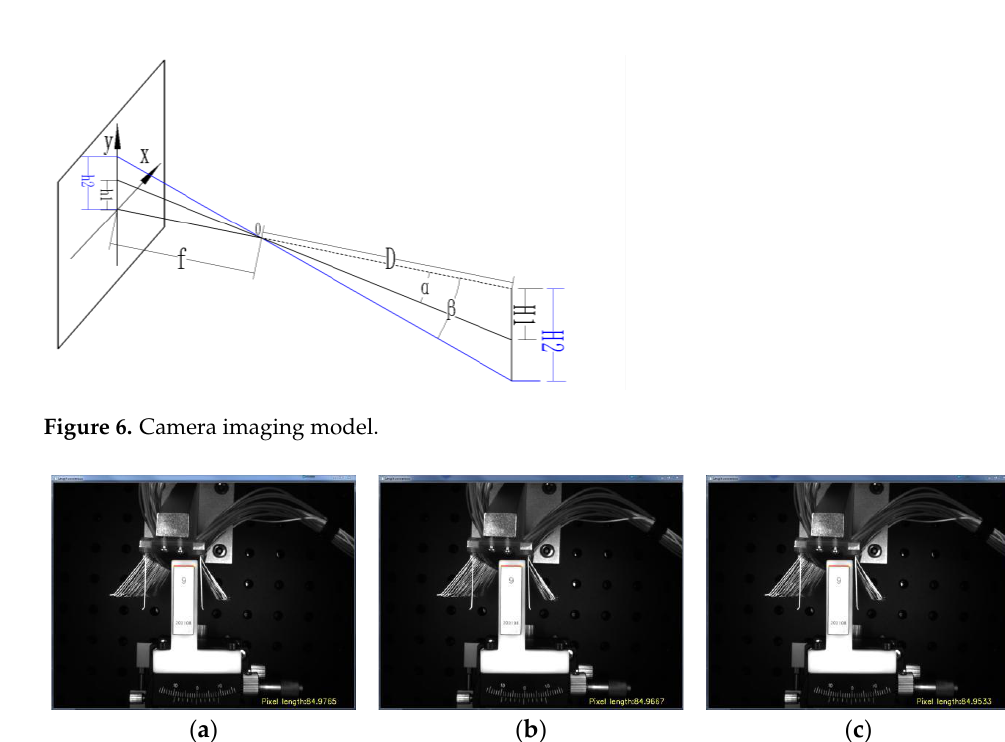
Figure 7. Measurement results of block length: ( a ) The 1st experiment, ( b ) the 4th experiment, and ( c ) the 8th experiment.